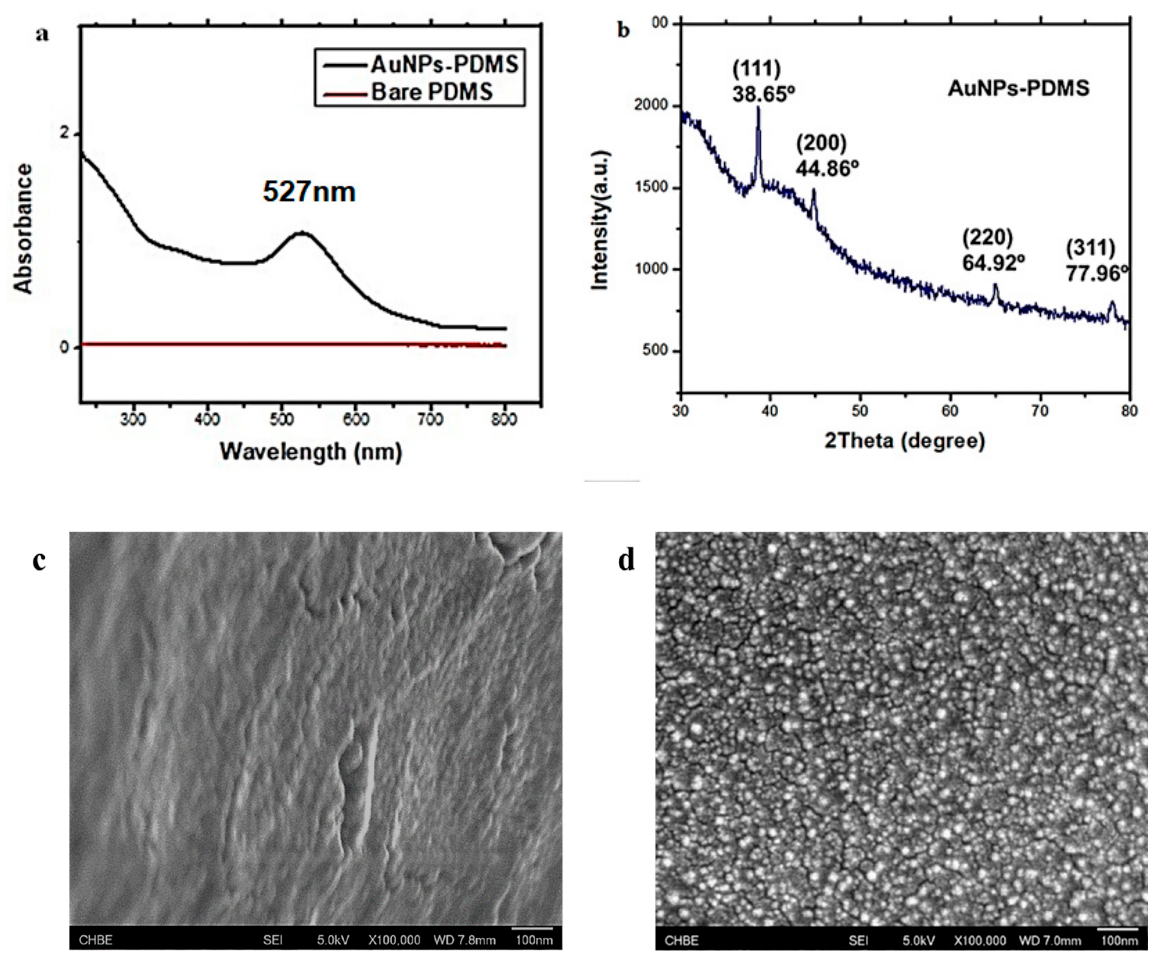
Figure 2. UV-vis absorption spectra. ( a ) UV-Vis spectra of bare PDMS and AuNPs–PDMS, ( b ) XRD of AuNPs–PDMS, ( c ) FeSEM image of bare PDMS and, ( d ) AuNPs–PDMS composite.